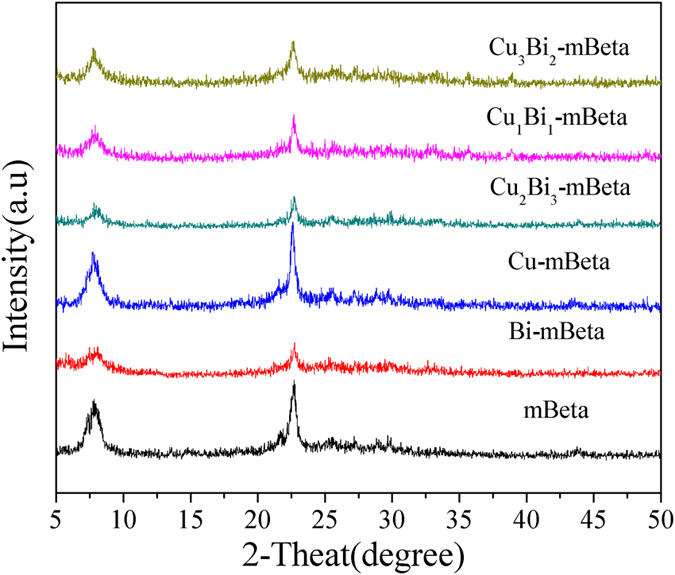
XRD patterns of samples mBeta, Cu-mBeta, Bi-mBeta and CuxBiy-mBeta.